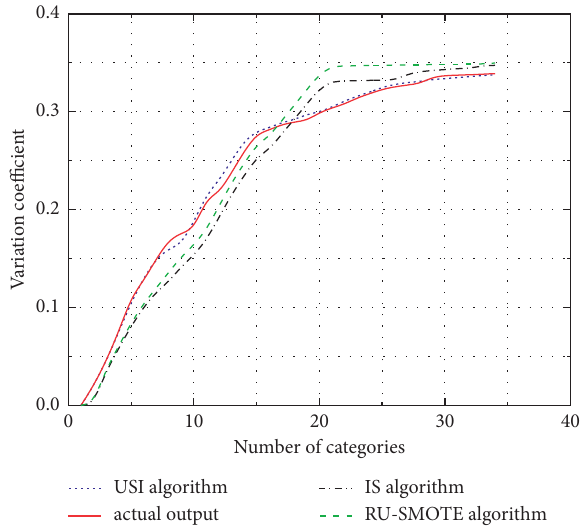
Figure 5: Performance comparison of different